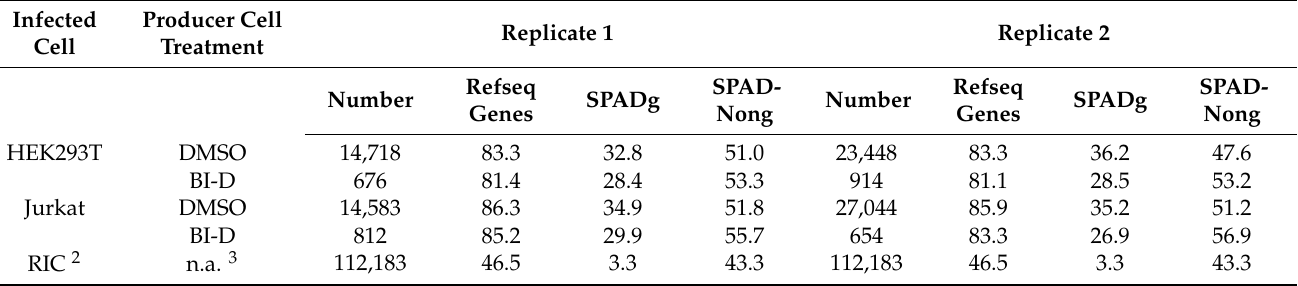
Table 2. Integration sites derived from BI-D-treated virions 1 .